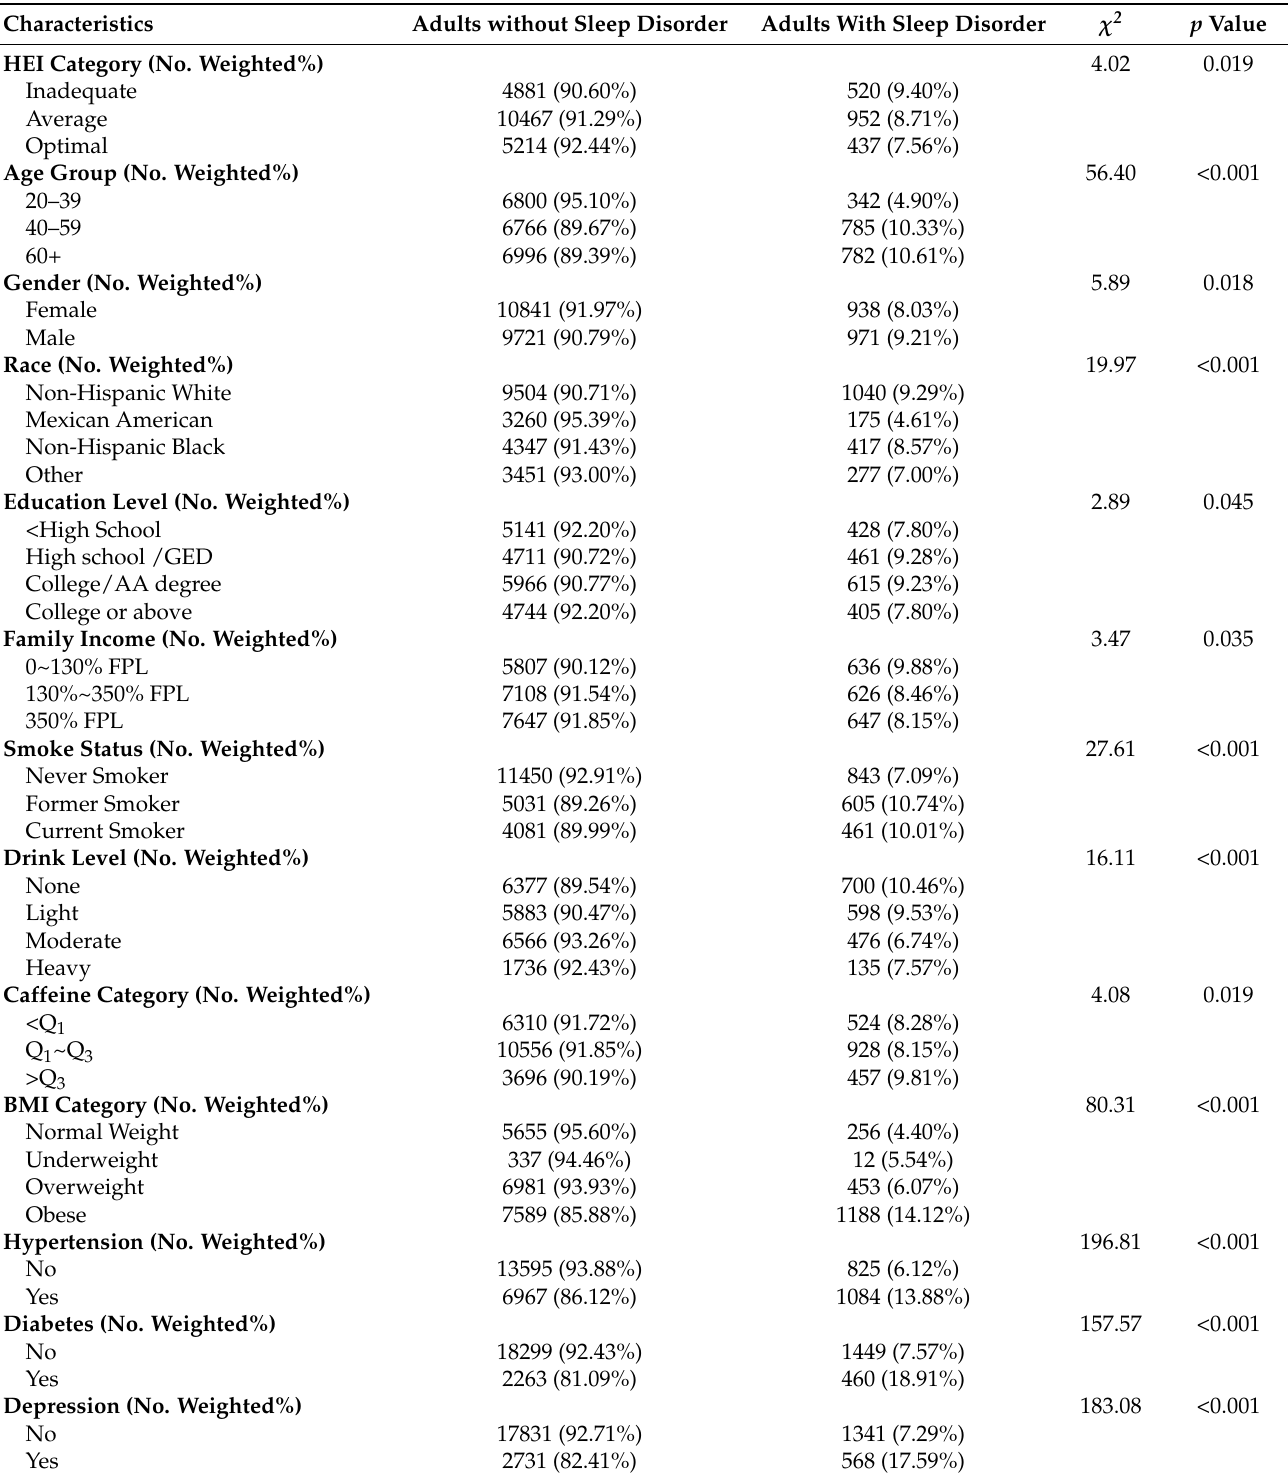
Table 2. Characteristics of adults aged 20+ years by sleep